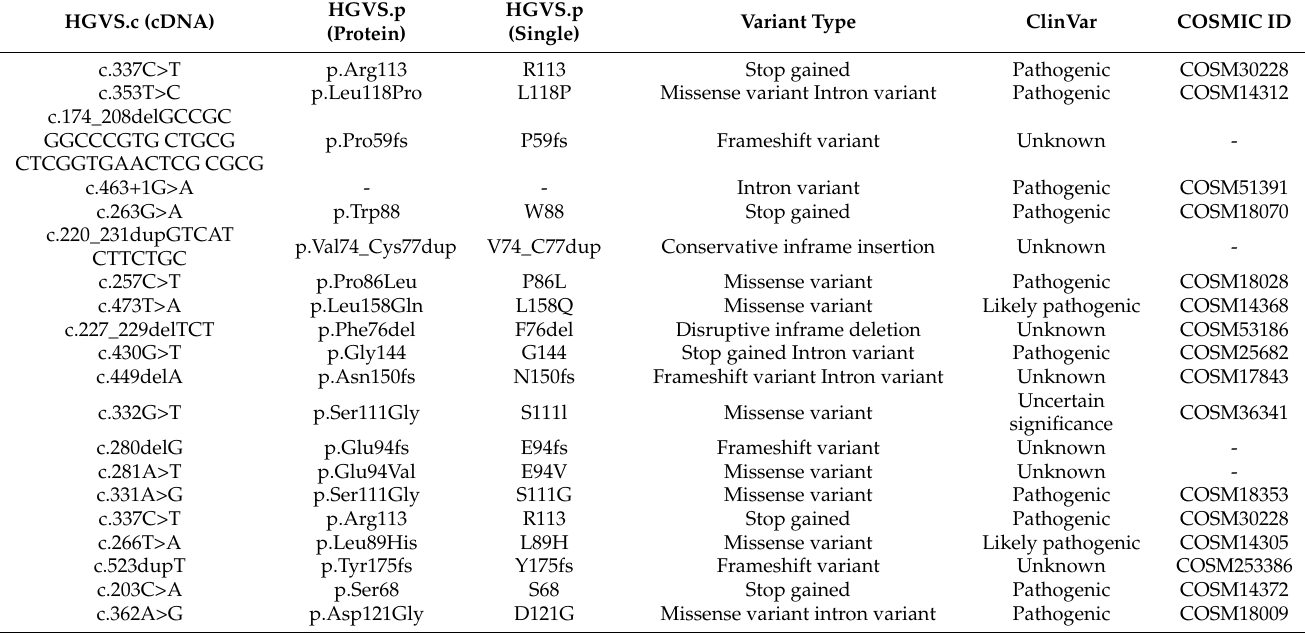
Table 3. Types of mutations in VHL genes found in 22 Korean patients with clear cell renal cell carcinomas.